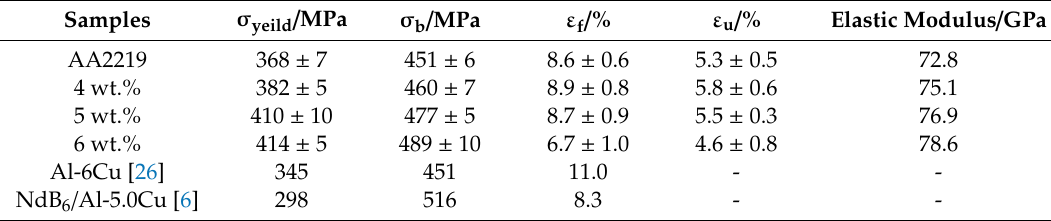
Table 3. Tensile test data and elastic modulus of AA2219 alloy and the composite.